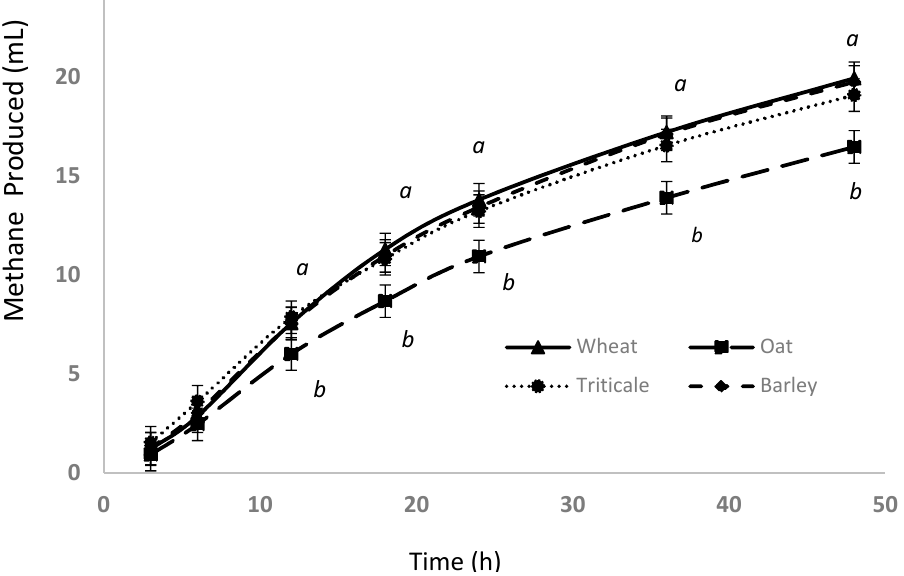
Figure 3. Cumulative methane production of whole-plant cereal crops grown and harvested over two locations in central Alberta. Means without a common letter differ at p < 0.05 (a,b).